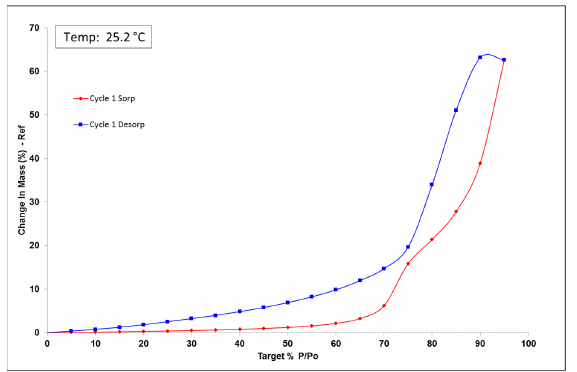
Figure 4. Amiodarone powder formulation dynamic vapor sorption (DVS) isotherm plot, sorption in red and desorption in blue. TGA analysis did not show variations in water adsorption depending on the powder storage. However, powder weighing was a useful tool to observe the change in the pow-